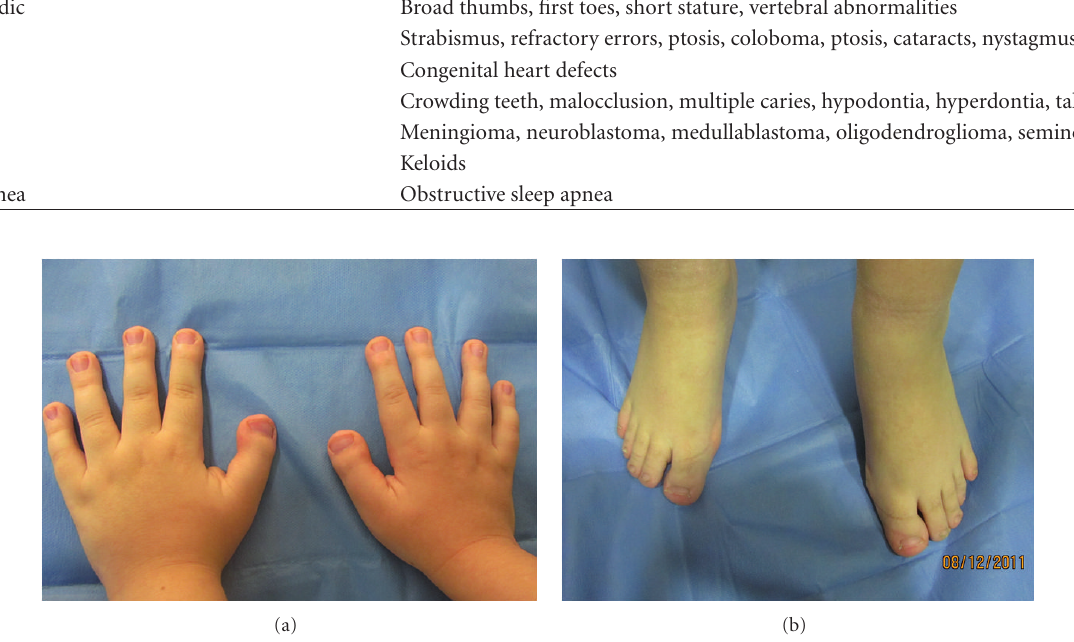
Figure 1: Hands and feet in RTS. Broad thumbs, broad terminal phalanges were seen.